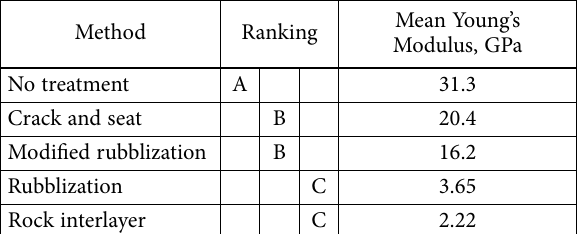
Table 2. Layer moduli and ranking